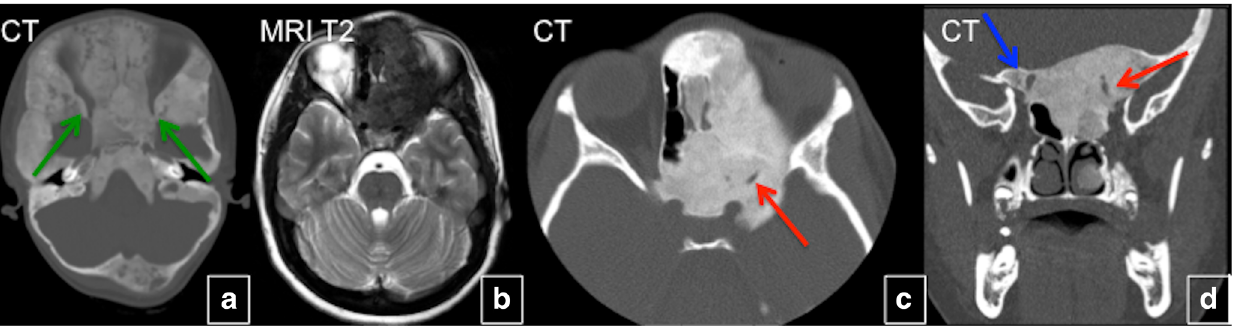
body of the sphenoid bone with marked narrowing and deformity of the left optic canal, causing left-sided blindness ( red arrows ). The right optic canal is narrowed ( blue arrows ). Vision in the right eye is preserved